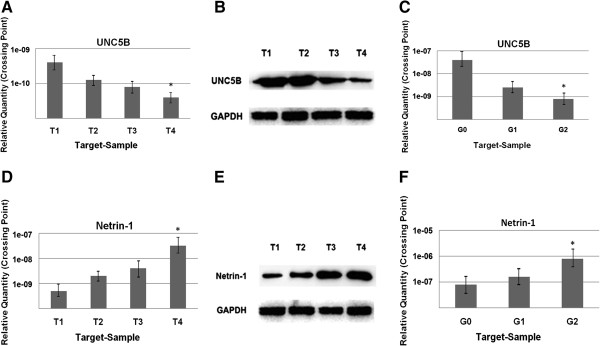
Expressions by RT-PCR and western blot in different stages and grades. (A) UNC5B expression was different in BC specimens with different clinical pathological stages (T1, T2, T3 & T4) at mRNA level. Data was analyzed by Student’s t test and shown as mean ± SD of ten independent experiments. UNC5B expression in stage T4 was much less than in T1–T3 stages (P < 0.05). *P < 0.05 compared with stage T1 BC tissues (paired t-test). (B) Different expressions of UNC5B in pT stage were detected by western blot and UNC5B expression in stage T4 was sharply less than in T1–T3 stages (P < 0.05). (C) UNC5B mRNA expression was determined by RT-PCR in different grades (G1, G2 & G3). Differences at G1 & G3 were significant. *P < 0.05 compared with G1 BC tissues (paired t-test). (D) Netrin-1 expression was different in BC specimens with different pT stage at mRNA level by RT-PCR. Stage T4 was more than in T1–T3 stages (P < 0.05). (E) Western blot was used to detect netrin-1 expression in different stages. The band intensities indicate netrin-1 expression more in stage T4. (F) Netrin-1 expression was determined by RT-PCR in different grades (G1, G2 & G3), and G3 was the highest (P < 0.05). *P < 0.05compared with G1 BC tissues (paired t-test). All data are representative of 3 individual experiments.